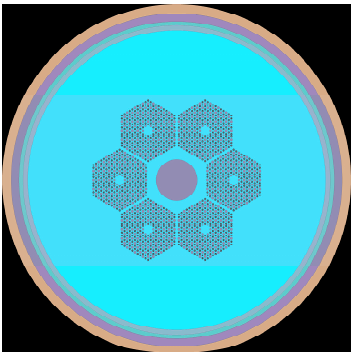
Figure 4. Serpent model of modified U-Battery with the central reflector removed.